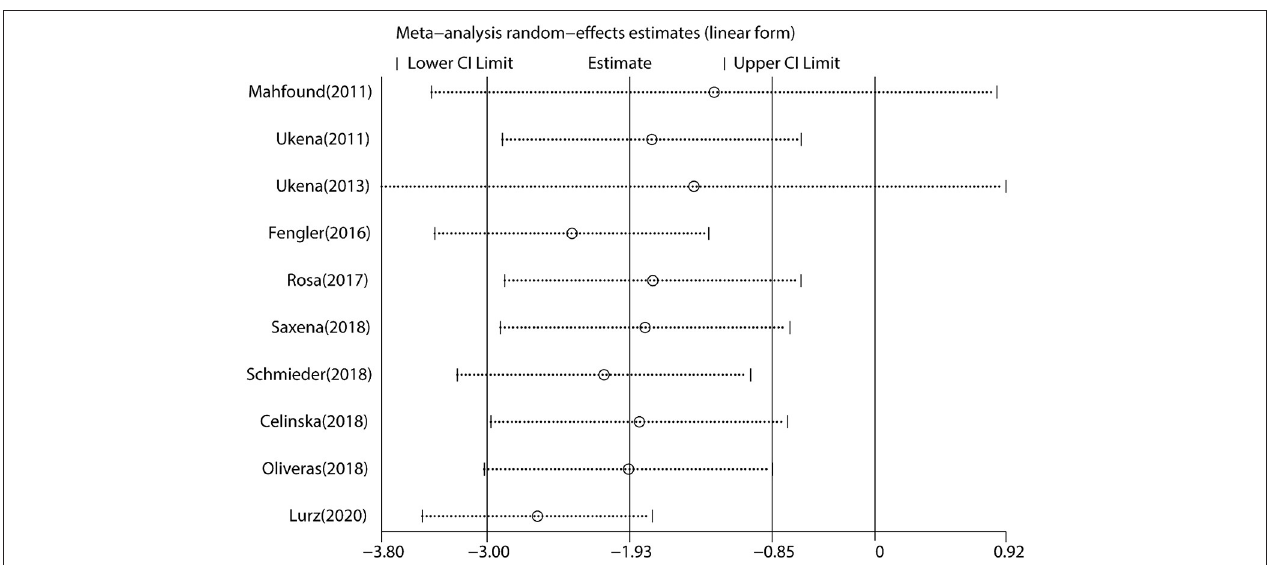
FIGURE 6 | Sensitivity